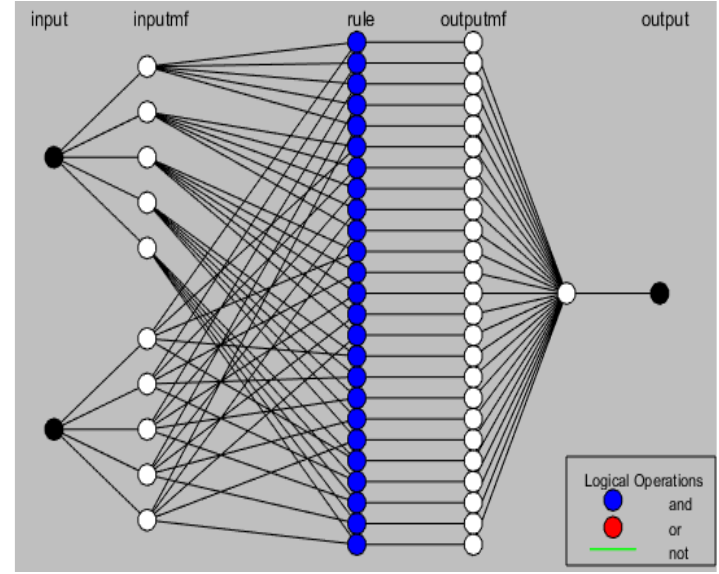
Table 3. P batt simulation results.